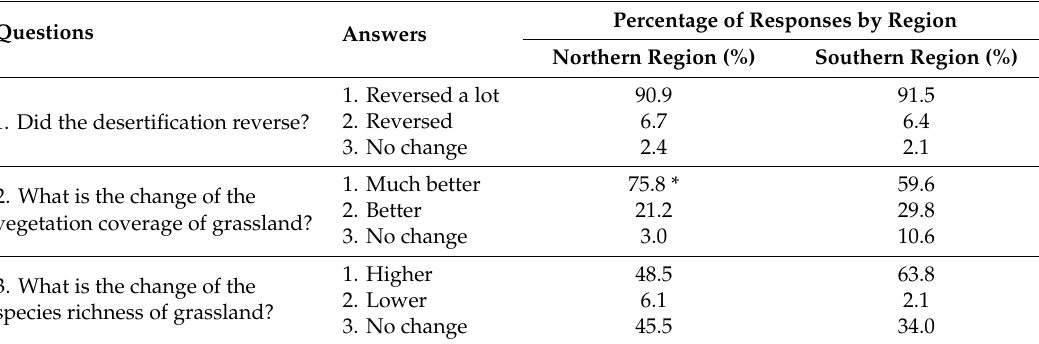
Table 2. Farmers’ perceptions of environmental changes after the